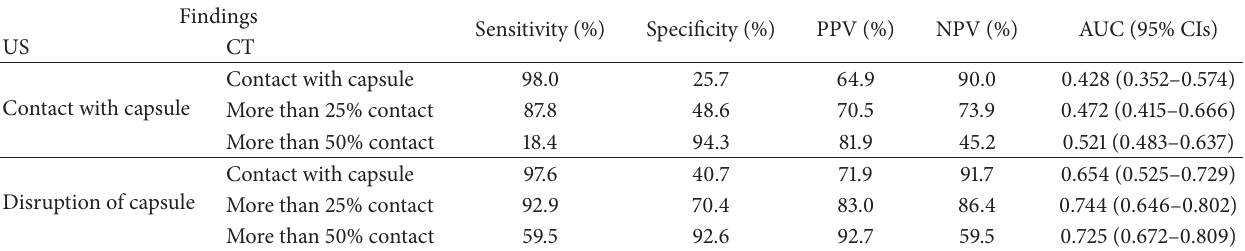
Table 3: Diagnostic accuracy of combining the preoperative US and CT to predict the extrathyroidal